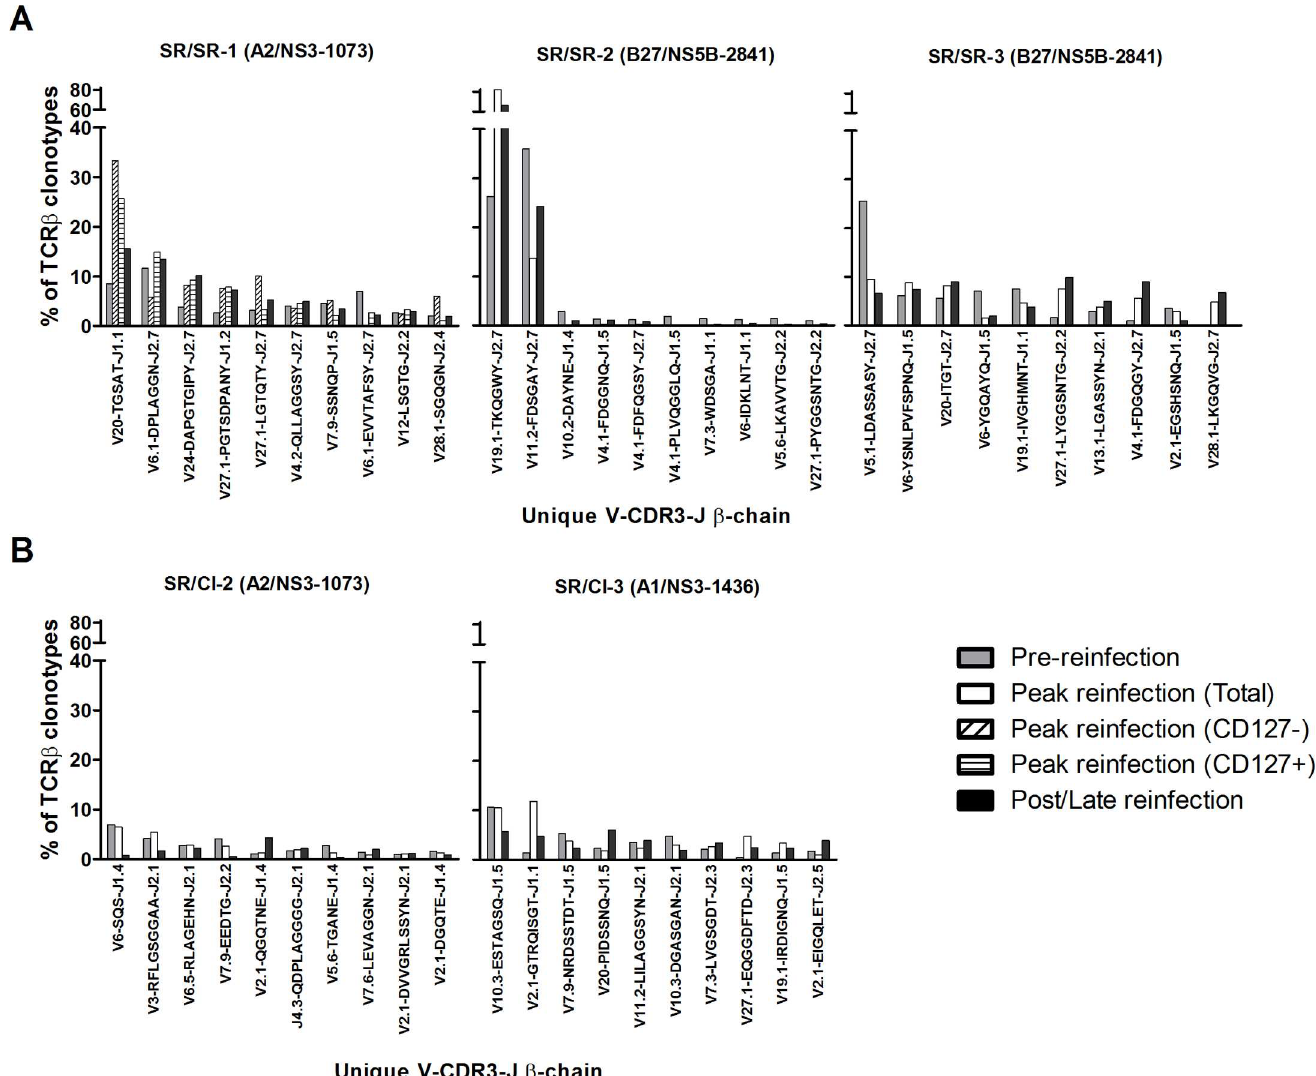
Fig 1. HCV-specific tetramer+ CD8 T-cell clonotypes mobilized during the reinfection episode were exclusively recruited from the pre- existing memory population. The top ten dominant clonotypes(frequency (cid:21) 1%) isolateddirectly ex vivo from (A) three SR/SR patients and (B) two SR/CI patients followed-uplongitudinally duringreinfectionepisodeat pre-reinfection, peak expansionand post/late reinfection(all five patients). For patient SR/SR-1, at the peak of reinfection, cells were sorted accordingto CD127expressioninto CD127-population(effector population,diagonally stripped white bar) and CD127+(memory population,horizontally stripped white bar). Tetramers used in each patient are indicatedbetweenbrackets next to the patient number.